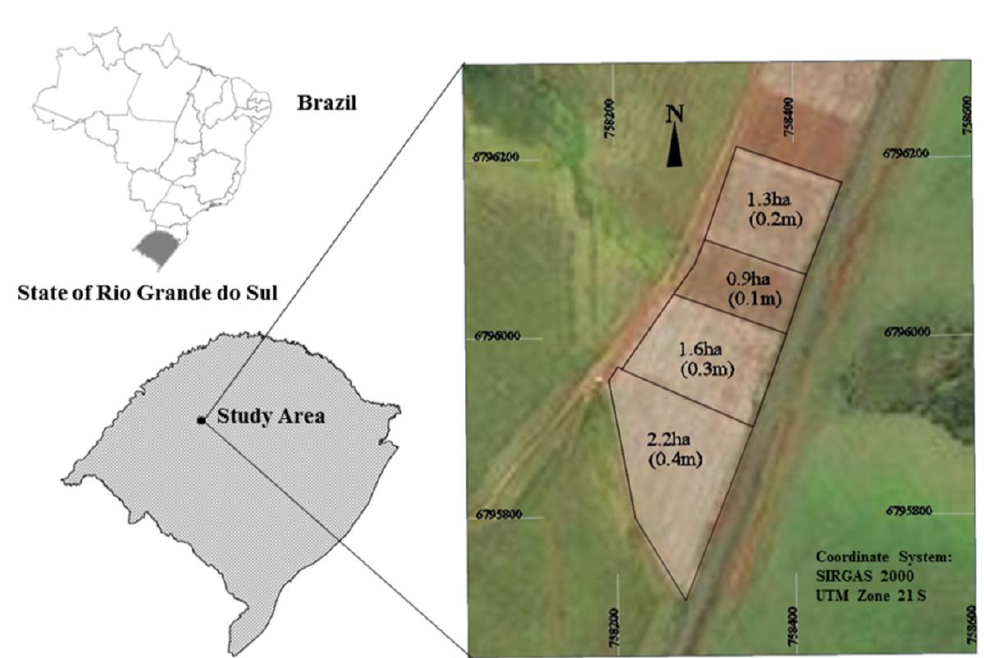
Figure 1. The location of the experimental area ( left ) and an aerial view of the paddocks ( right ) used for the description of the spatiotemporal patterns of dung deposition in the winter stocking period of an integrated soybean-beef cattle system in southern Brazil. Paddock dimensions and the target sward heights (0.1, 0.2, 0.3 and 0.4 m) assigned to them are shown in the aerial view. The pastures consisted of a mixture of black oat ( Avena strigosa Schreb.) and Italian ryegrass ( Lolium multiflorum Lam.) grazed by steers under continuous stocking method. Table 1. The average number of animals (beef steers) per paddock at each dung sampling date in 2010 for the di ff erent grazing intensities (sward heights of 0.1, 0.2, 0.3 and 0.4 m) on mixed black oat ( Avena strigosa Schreb.) and Italian ryegrass ( Lolium multiflorum Lam.) pastures in the stocking period of an integrated soybean-beef cattle system in southern